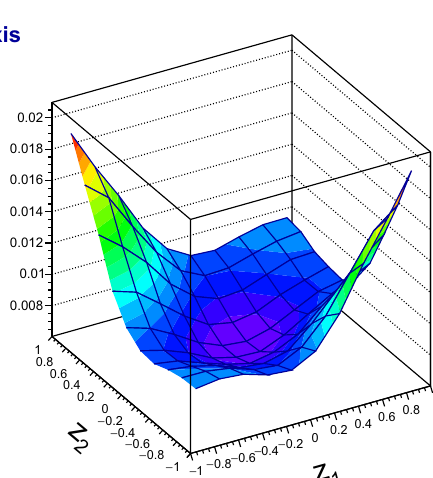
Fig. 5 Interference corrections (cid:9) int for the K (top), R (middle) and N (bottom) axes, normalised to the total number of events in the SM